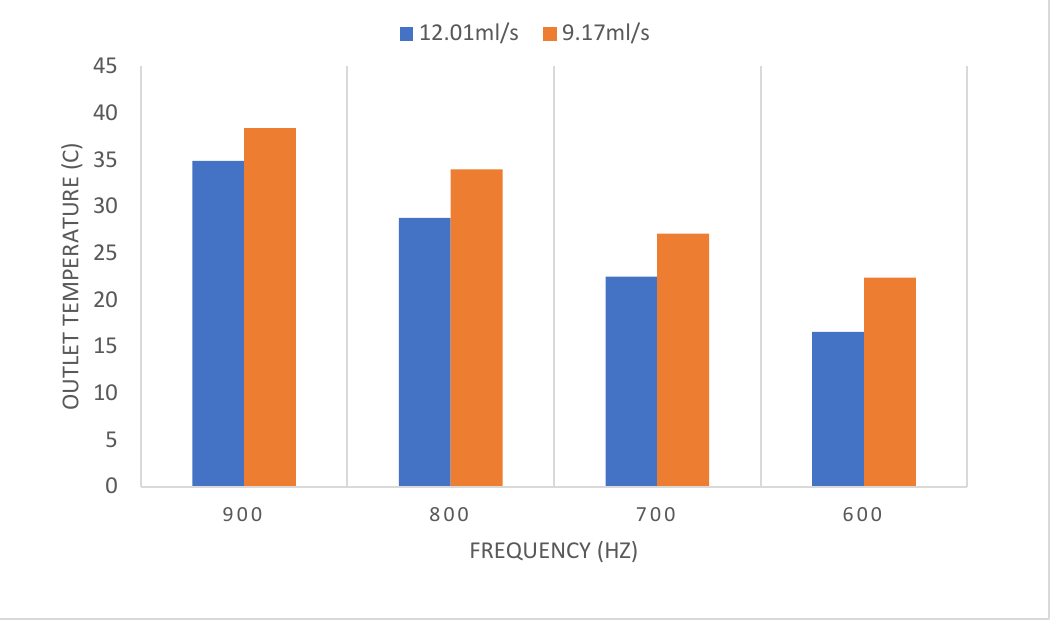
Figure 7. The outlet temperatures using different flow rates and frequencies for a field intensity of 25 kV/cm on the E. coli population suspended in diluted protein shake drink.